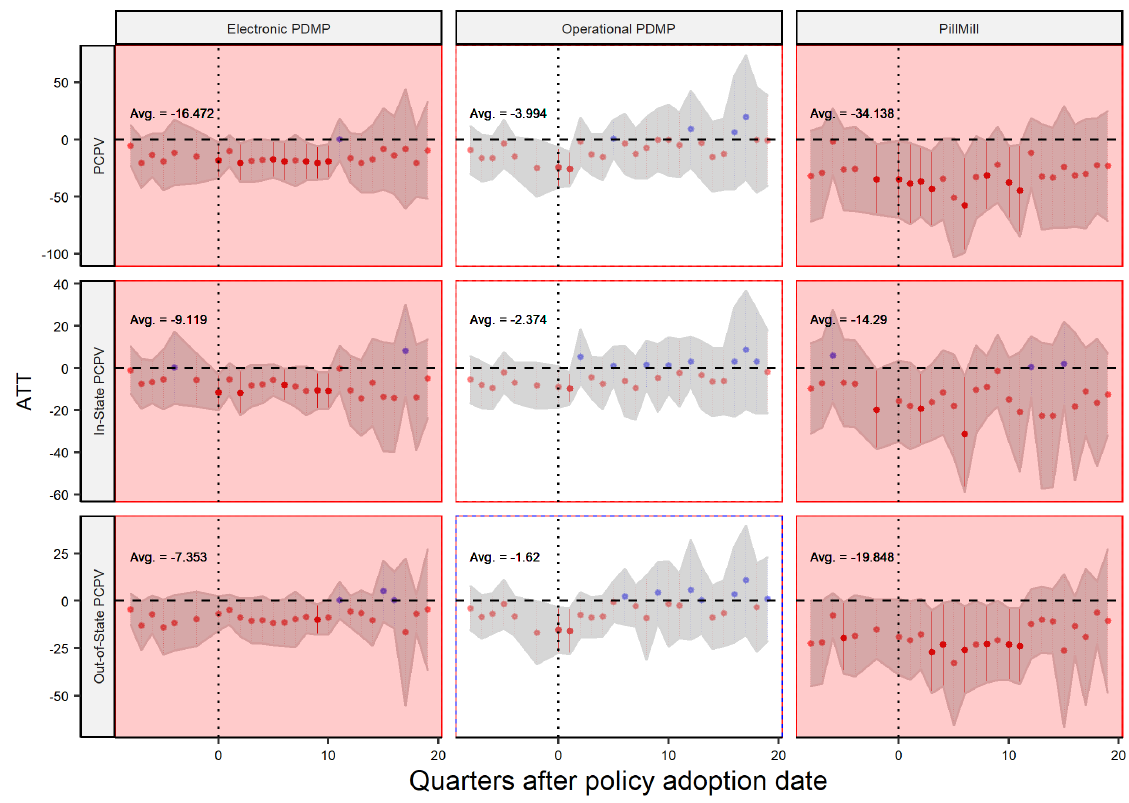
Figure 7. Policy Effect—Player: